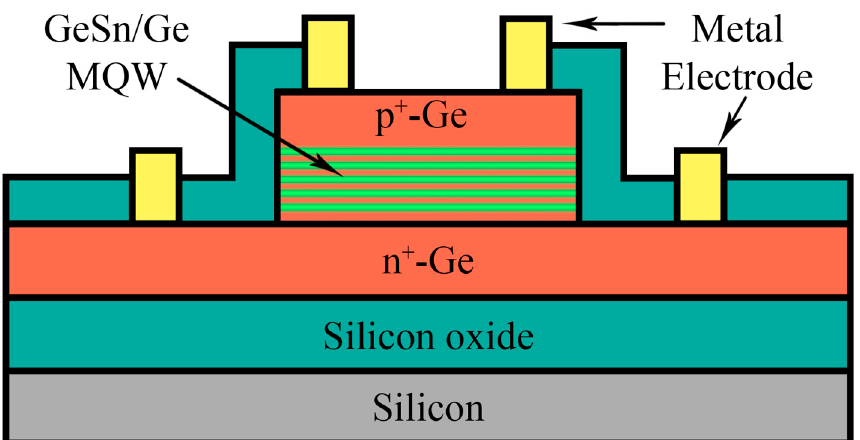
Figure 4. Scheme of the black silicon Ge-on-Si photodiode.